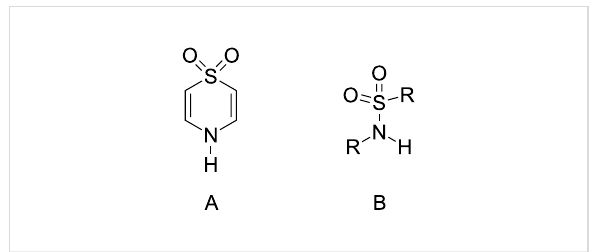
Figure 1: Structures of thiazine-1,1-dioxide heterocycle (A) and sulfon- amide function